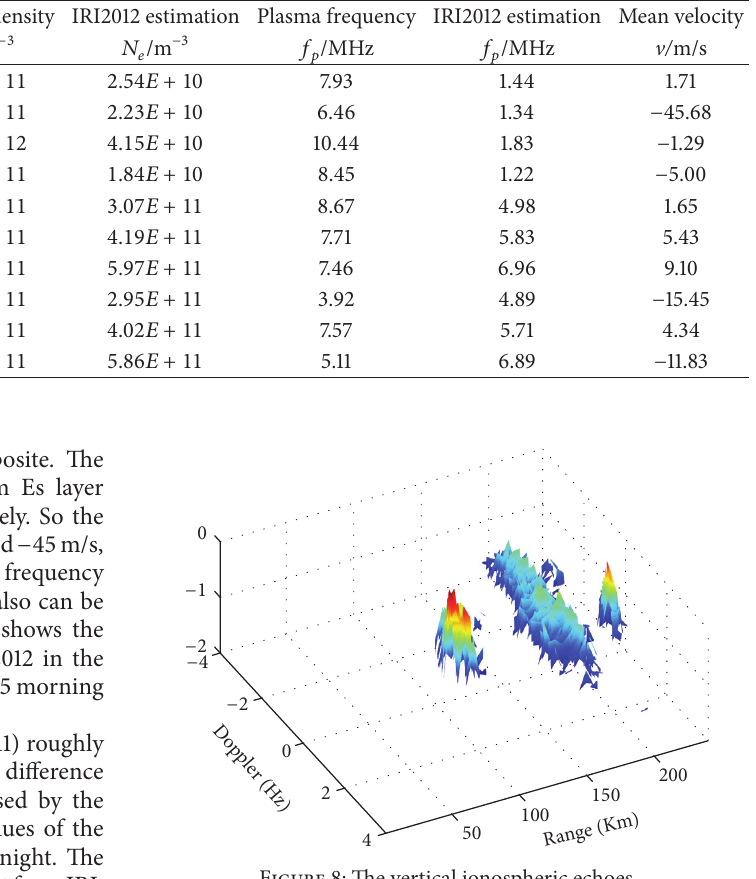
Figure 8: The vertical ionospheric